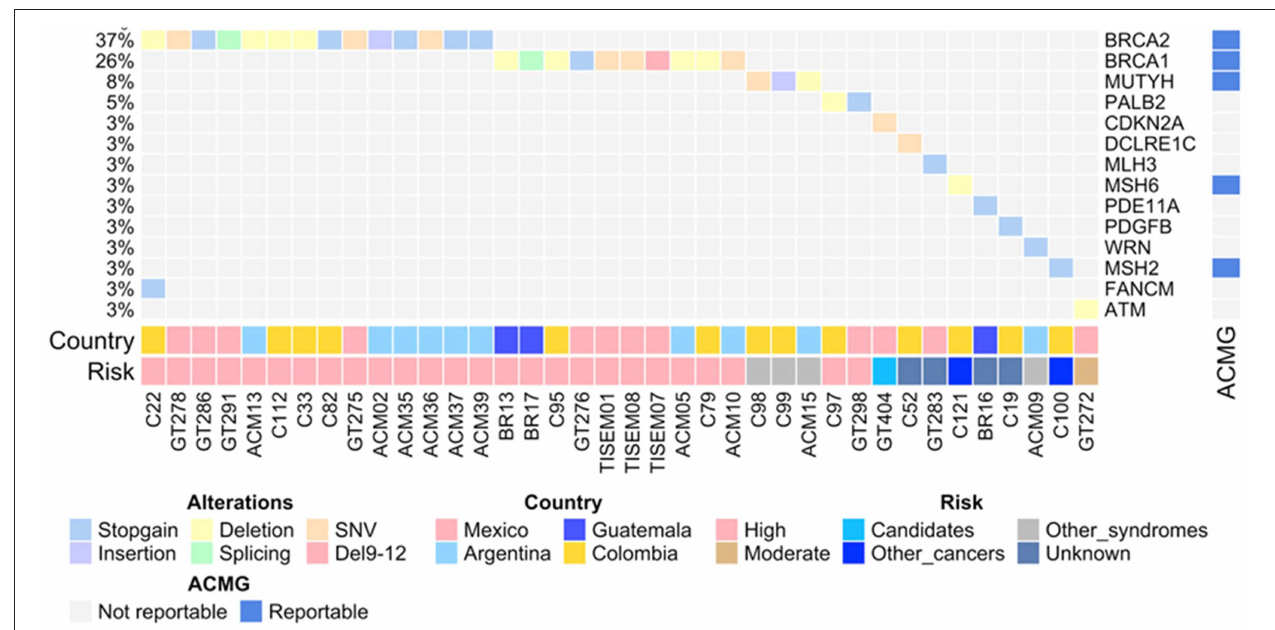
FIGURE 1 | The OncoPrint shows the allelic distribution of the pathogenic variants in patients with cancer. The grid panel depicts the pathogenic mutations found in each patient color-coded for each type. Right panel: gene reportable by the suggestion of the ACMG (blue: yes, gray: no). Bottom axis: patient ID. Left axis: relative frequency of mutations per gene. Right axis: mutated gene. Right bar plot: absolute frequency and type of pathogenic mutation per gene. Bottom panel indicates: Country; risk associated with the